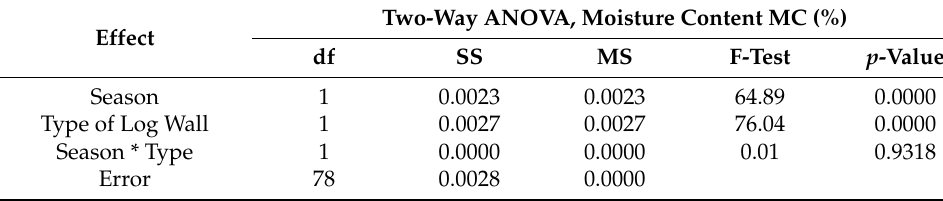
Figure 8. The Moisture Content of the Fiberboard Insulation in Service Cavity. Table 2. Results of ANOVA for the insulation STEICO Flex width 40 mm.